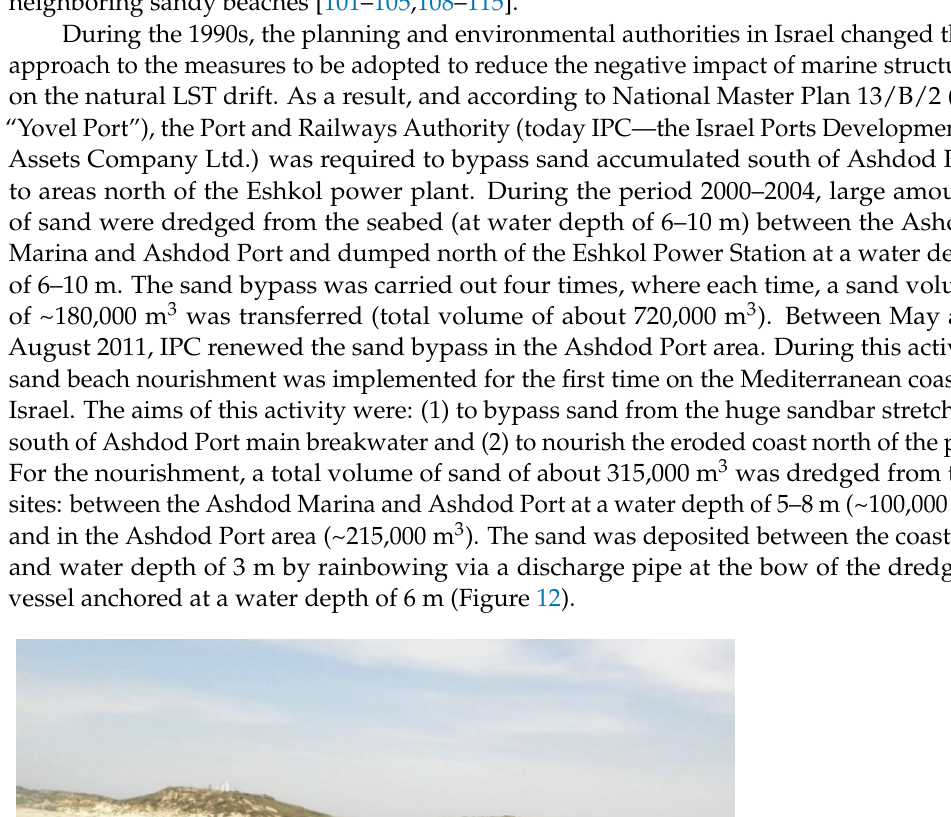
Figure 13. Beachrock coast north of Ashdod Port ( A ) during nourishment operation (May–August 2011) and ( B ) in May 2012 (photograph by Dov Zviely).